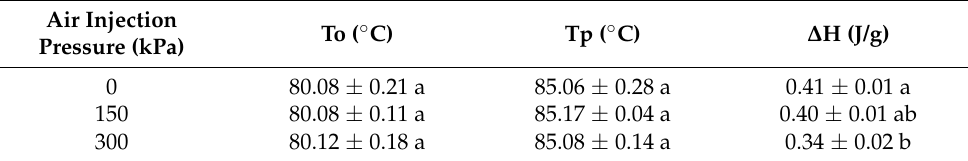
Table 2. Thermal properties of extruded yellow pea flours produced at a die temperature of 120 ◦ C with small flour particle size and as a function of air injection pressure. Air